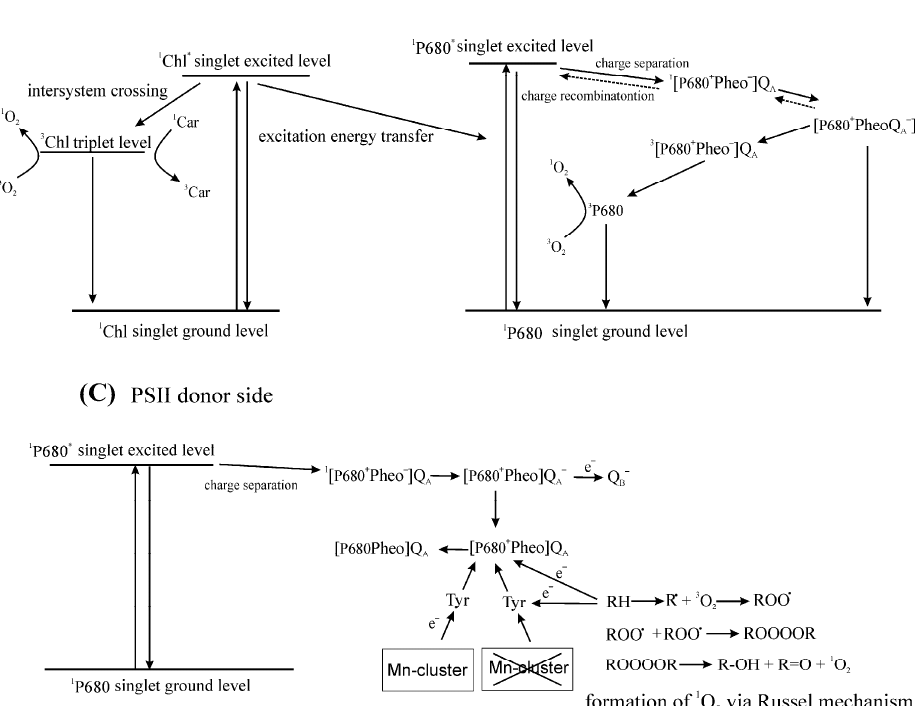
Figure 1. Singlet oxygen ( 1 O 2 ) generation in the antenna complex ( A ) and in the reaction center of PSII via charge recombination reactions ( B ). Proposed mechanism for the formation of 1 O 2 on the donor side of PSII via formation of organic peroxyl radicals ( C ). ( A ) In the antenna complex, the absorption of a photon by a molecule of Chl leads to the formation of a singlet excited state, 1 Chl*, that can transform to the triplet state 3 Chl via intersystem crossing. The formation of 1 O 2 via intersystem crossing has been demonstrated to occur in isolated LHCII [164,165]. ( B ) In the reaction centre of PSII, [P680 + Pheo − ] is originally formed via electron transfer from 1 P680* to Pheo in a virtual singlet state 1 [P680 + Pheo − ] that recombines to 1 P680*. Charge recombination of P680 + PheoQ A − ] causes the formation of 1 [P680 + Pheo − ]. The long lifetime of the state [P680 + PheoQ A − ] destroys spin correlation, and therefore the recombination [P680 + PheoQ A − ] to 1 [P680 + Pheo − Q A ] often produces a “virtual triplet state” of the primary radical pair, i.e., a radical pair with such a spin configuration that, in its recombination to an excited state of the primary donor, produces a triplet, 3 P680 [172–174]. ( C ) On the donor side of PSII, carbon centered radicals (R • ) can be formed via the oxidation of lipids and proteins by P680 + if electron donation from Mn-cluster to P680 + does not function. R • are able to react with O 2 to form peroxyl radical (ROO • ). Two peroxyl radicals react with each other to form linear tetraoxide (ROOOOR) that decomposes to 1 O 2 , carbonyl (R = O) and alcohols (R–OH) via the Russell mechanism [200–202].